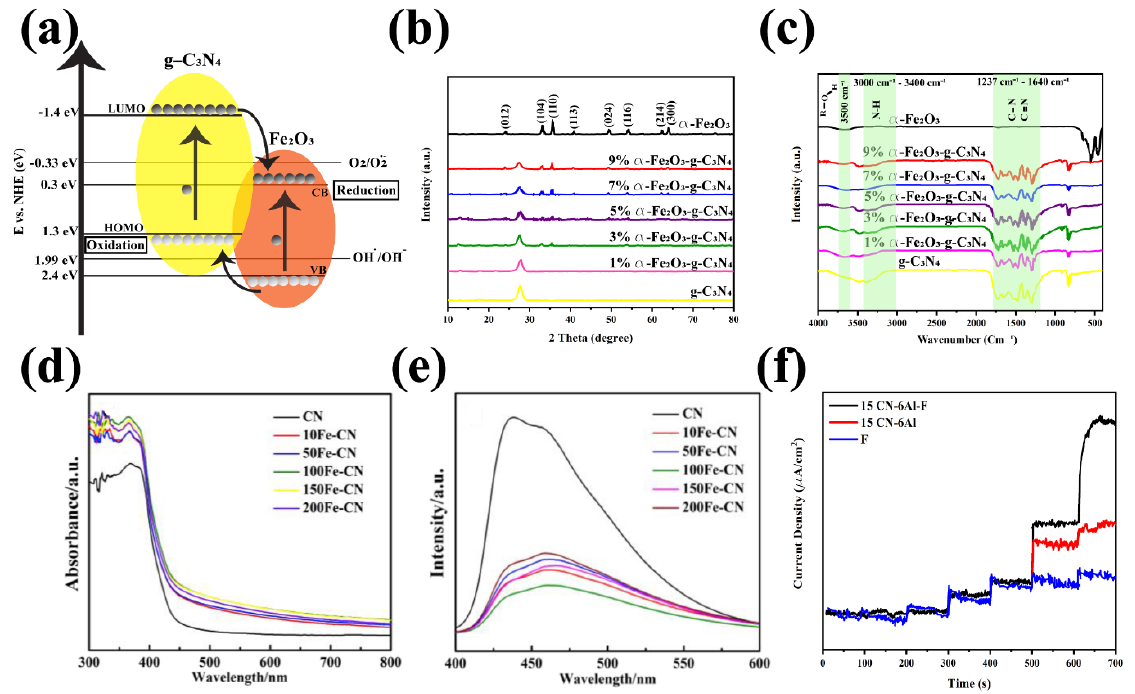
Figure 14. ( a ) Proposed structure of g-C 3 N 4 -FeO x heterojunction interface; ( b ) XRD patterns and ( c ) FT-IR spectra of g-C 3 N 4 , α -Fe 2 O 3 , and α -Fe 2 O 3 / g-C 3 N 4 composites, Copyright © 2022 Elsevier [220]; ( d ) UV-Vis diffuse reflection absorption spectra; ( e ) PL spectra of CN and xFe-CN samples with an excitation wavelength of 380 nm, Copyright © 2022 Elsevier [221]; ( f ) single-wavelength photocurrent response of F, 15CN-F and 15CN-6Al-F, Copyright © 2022 Elsevier [222].